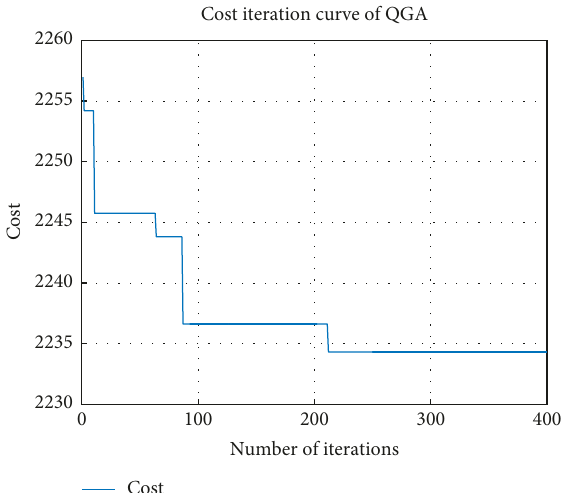
Figure 7: Pareto solution set of the multiobjective quantum genetic algorithm.